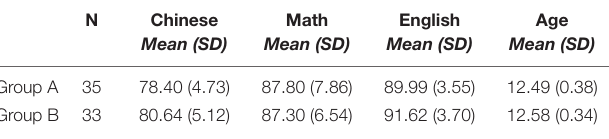
TABLE 1 | Academic scores of core subjects and